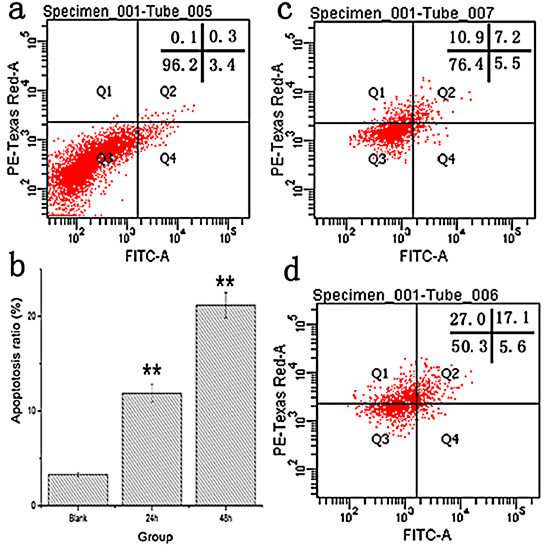
Figure 6. The antitumor activity of M2 on HT-29 cells after different incubation periods and at different concentrations in 3-(4,5-cimethylthiazol-2-yl)-2,5-diphenyl tetrazolium bromide (MTT) assay.